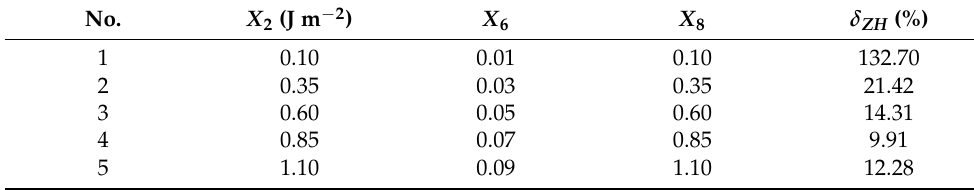
Table 5. Scheme and results of the steepest ascent test.